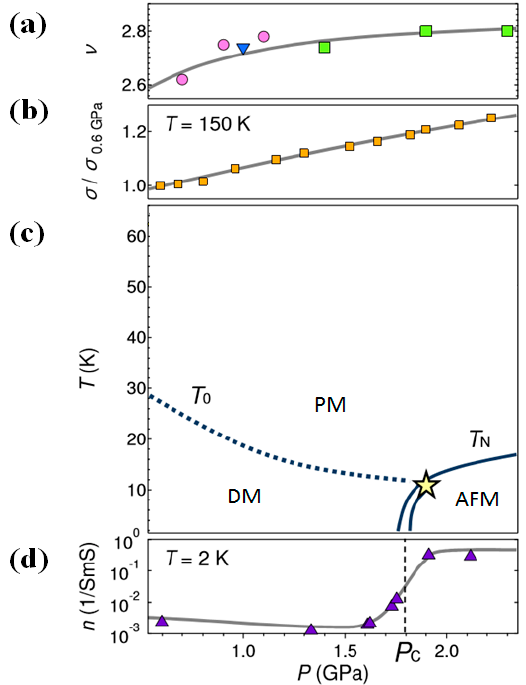
Figure 6. ( a ) Mean valence (already well above valence state 2) and ( b ) conductivity of SmS at the specific pressure interval between approximately 0.5 GPa and 2.4 GPa. Different shapes of ( a ) represent values coming from different works, cited in the original paper of Figure 6. Black line serves as a guide to the eye; ( c ) P-T phase diagram of the metallic phase, where PM: paramagnetic regime, AFM: antiferromagnetic regime and DM: diamagnetic regime; ( d ) Evolution of the number of free carriers (n) at T = 2 K. (Reprinted with permission from [50].)